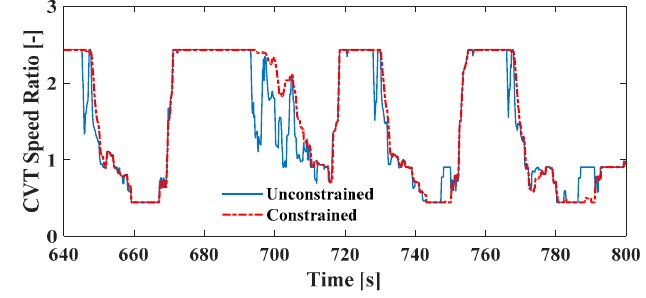
Figure 11. Comparison of the CVT speed ratio.